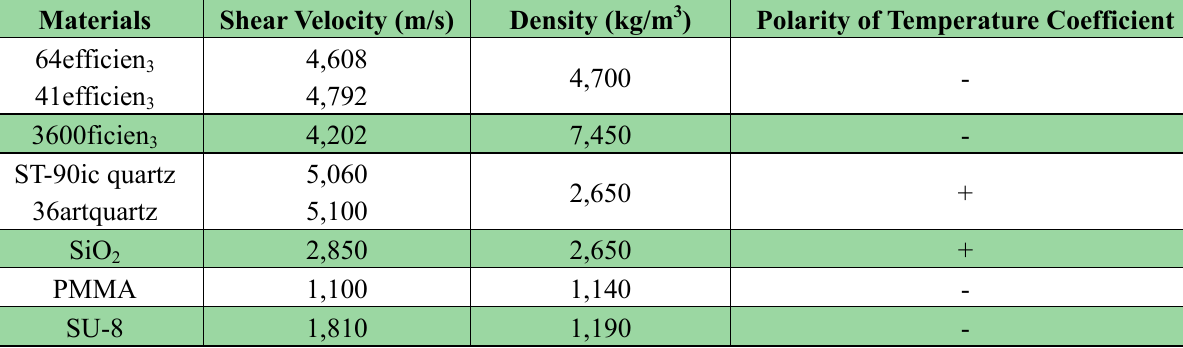
Table 1. Physical parameters of the materials for guide layer and